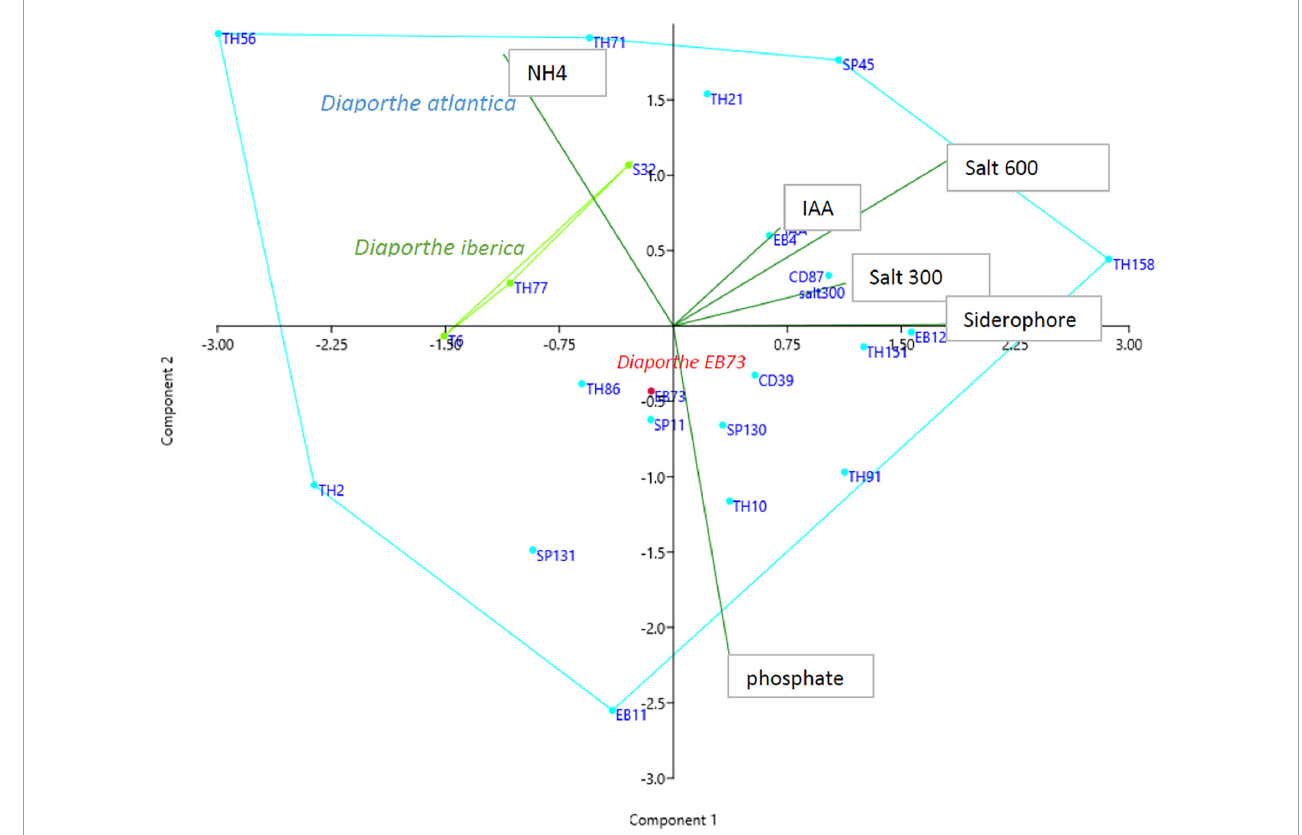
FIGURE5 Principal component analysis of in vitro characteristic of Diaporthe strains isolated from Festuca pruinosa